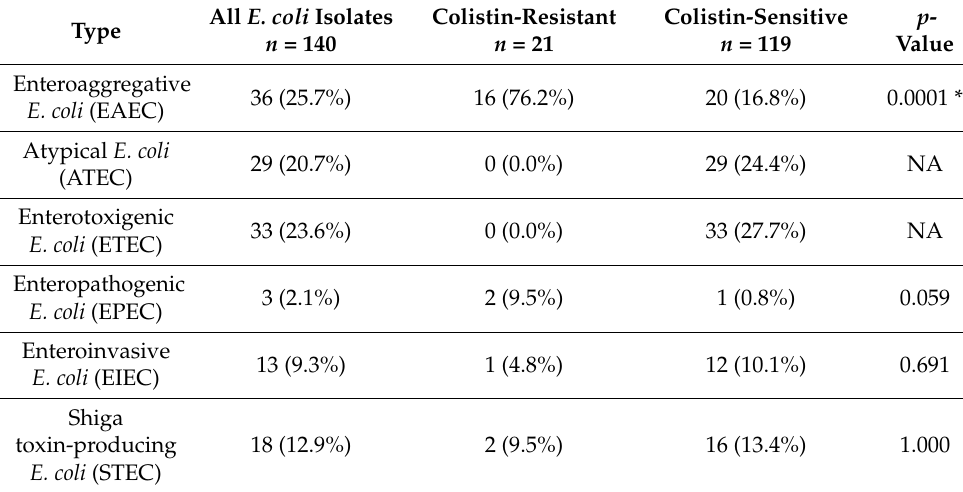
Table 5. Colistin resistance among the different E. coli